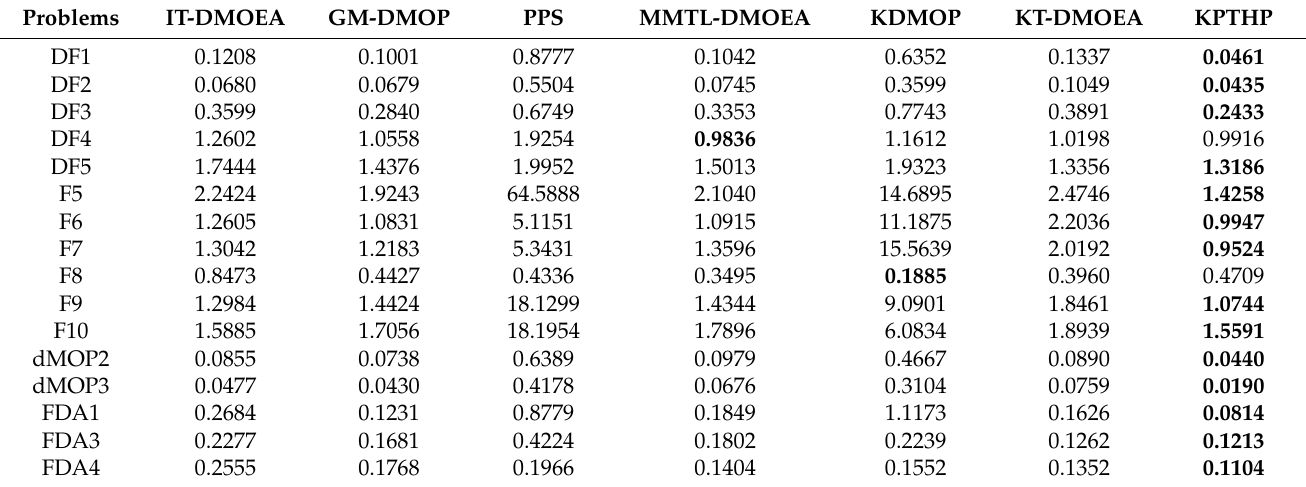
Table 5. DMIGD values obtained by seven